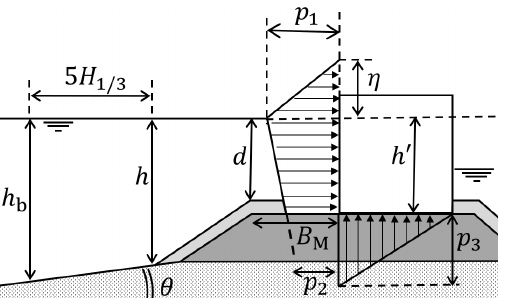
Figure 6. Distribution of horizontal wave pressures upon a vertical wall according to Goda